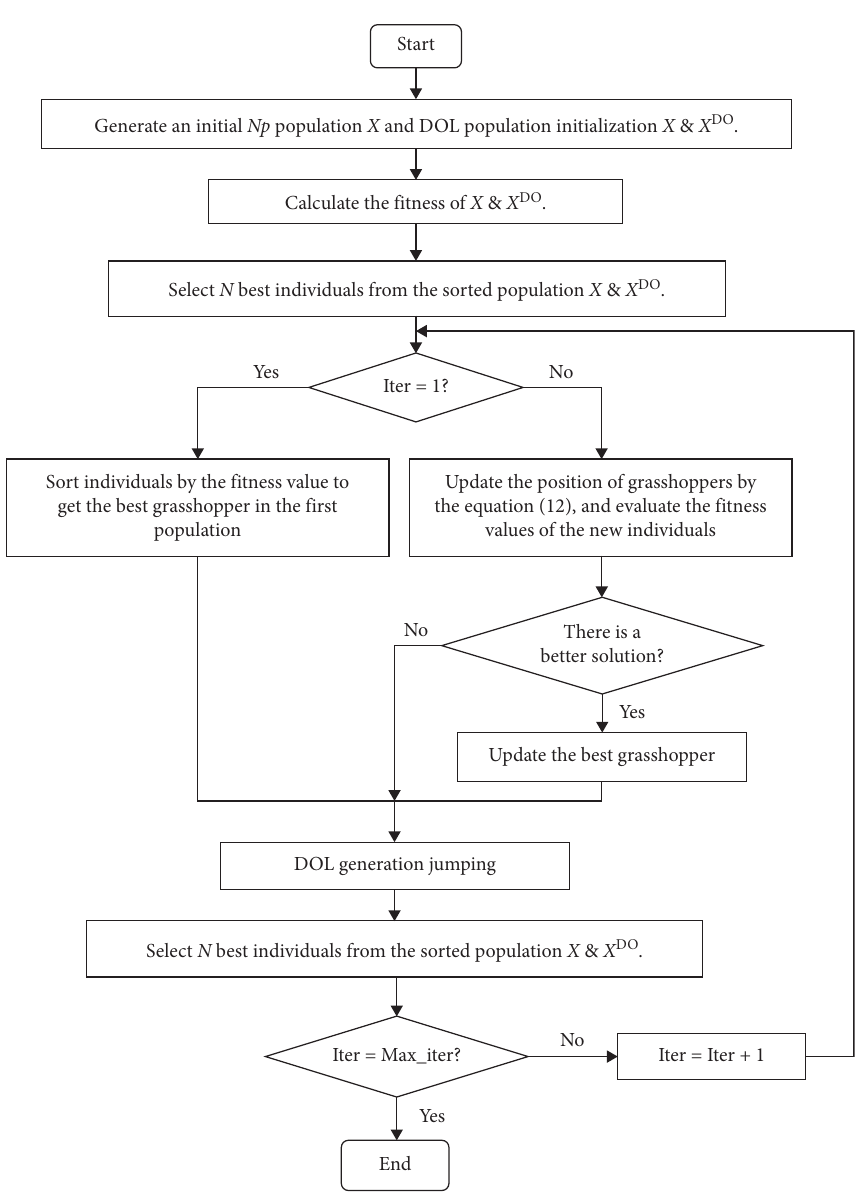
Figure 1: The flowchart of DOLGOA